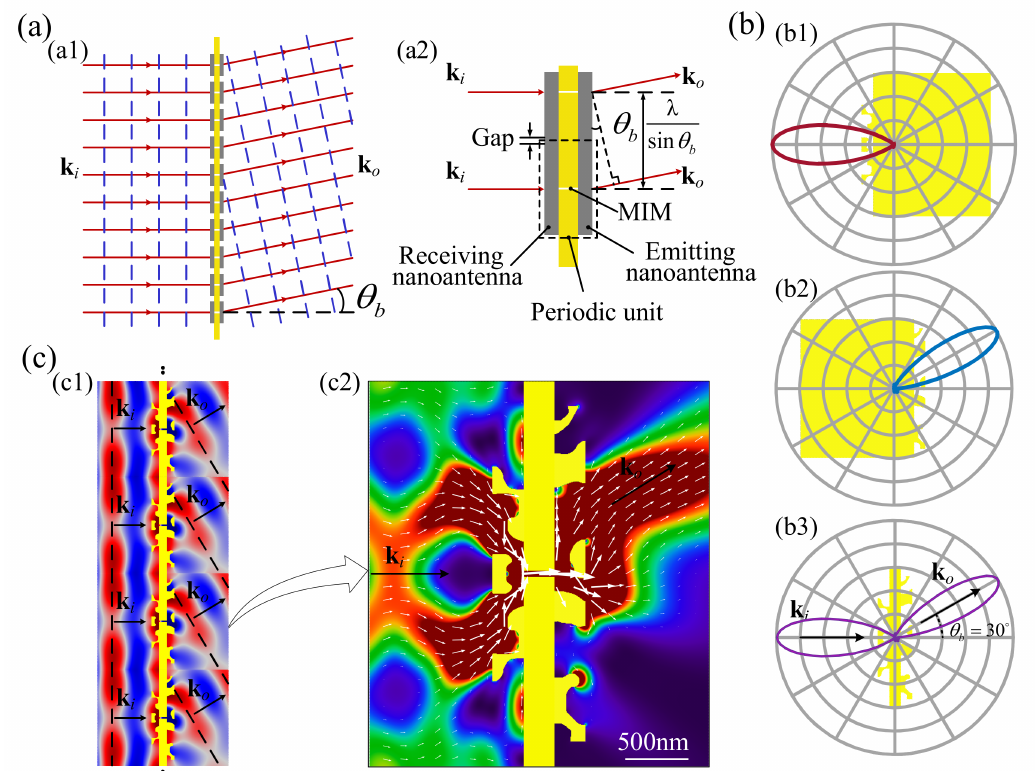
Figure 5. ( a ) Sketch of the meta-interface used to refract the propagation of light wave and two neighboring periodic units of the meta-interface. ( b ) Nanoantenna inversely designed and the conjugated structural unit of the meta-interface for the wavelength 1550 nm with the oblique angle 0 ◦ , together with its normalized polar diagram. ( c ) Meta-interface composed of the structural unit shown in Figure 5b3, together with the magnetic field around the meta-interface and the energy flux density around the structural unit, where the white arrows represent the Poynting